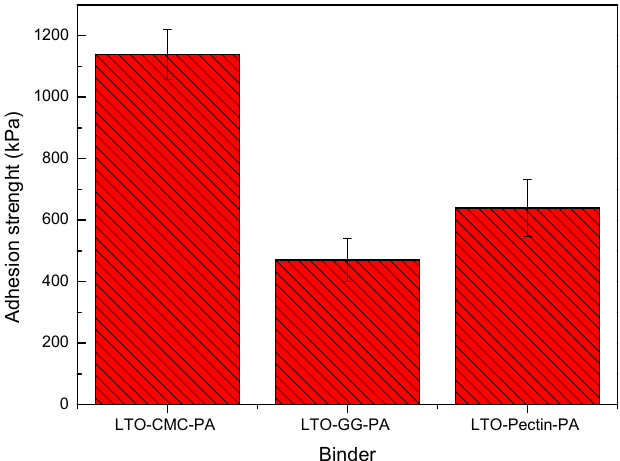
Figure 4. Adhesion strength of LTO electrodes fabricated using PA as an additive and CMC, guar gum and pectin as the binder.